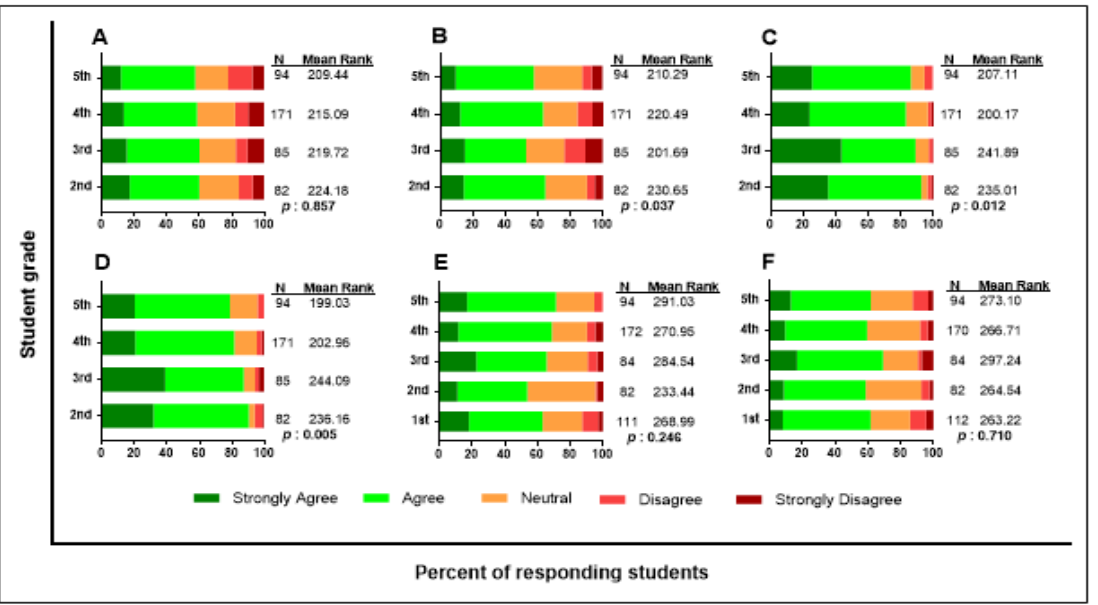
Figure 3. Student perceptions on the distance education experience during the academic year of 2020 -2021